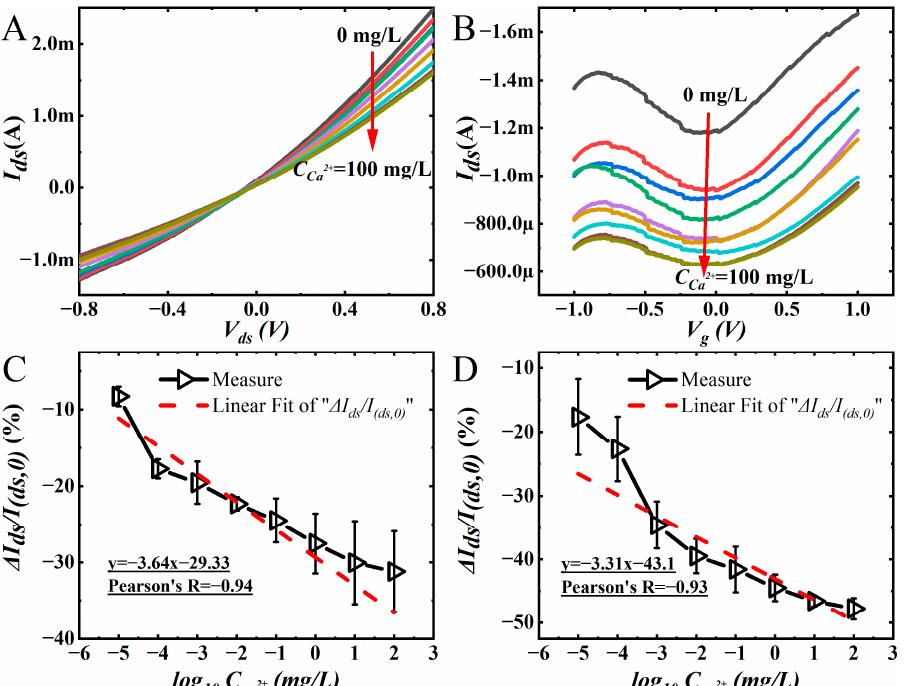
Figure 4. Sensor performance test: ( A )the output curve of Ca 2+ incubated on the surface of the sensor at different concentrations; ( B ) the transfer curve of Ca 2+ incubated on the surface of the sensor at different concentrations; ( C ) the ∆ I ds /I ( ds ,0) at different C Ca 2 + when V ds = 0.8 V on the output curve; ( D ) the ∆ I ds /I ( ds ,0) at Dirac point after incubation of Ca 2+ solutions ( C Ca 2 + = 10 − 5 –10 2